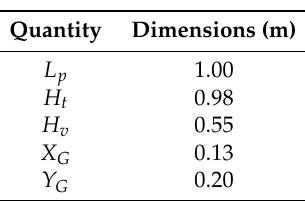
Figure 5. Reference axes for FAST tower references (black), and reference axes for accelerometer measurements (red). The figure is not drawn to scale. Table 1. Dimensions of the system, according to Figure 5.